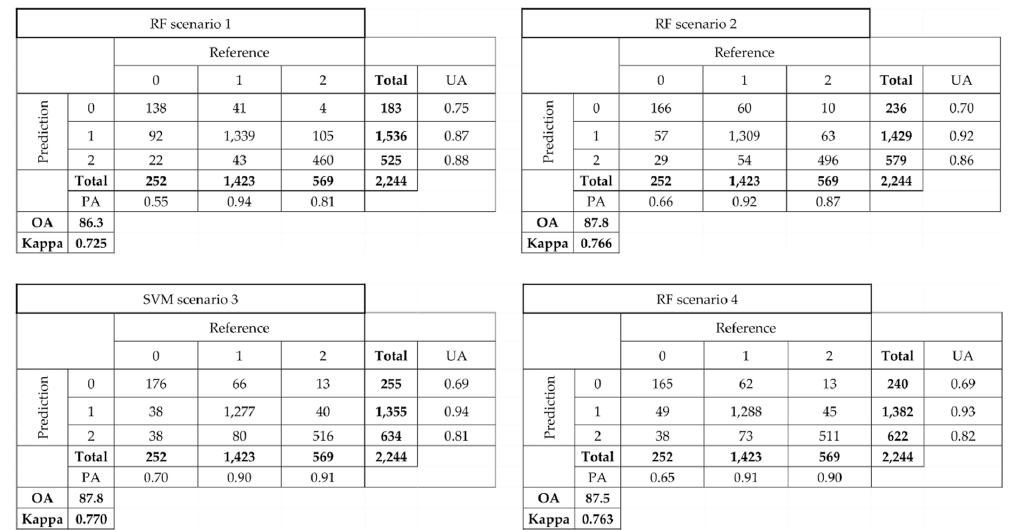
Figure 10. Confusion matrix, OA (%), PA, UA, and Kappa statistic for the best model associated with each scenario identified in Table 7. RF scenario 1: CI = (0.848, 0.877), McNemar's Test P-Value = 1.579e-12; RF scenario 2: CI = (0.864, 0.892), McNemar's Test P-Value = 0.018; SVM scenario 3: CI = (0.863, 0.891), McNemar's Test P-Value = 3.028e-07; RF scenario 4: CI = (0.861, 0.889), McNemar's Test P-Value